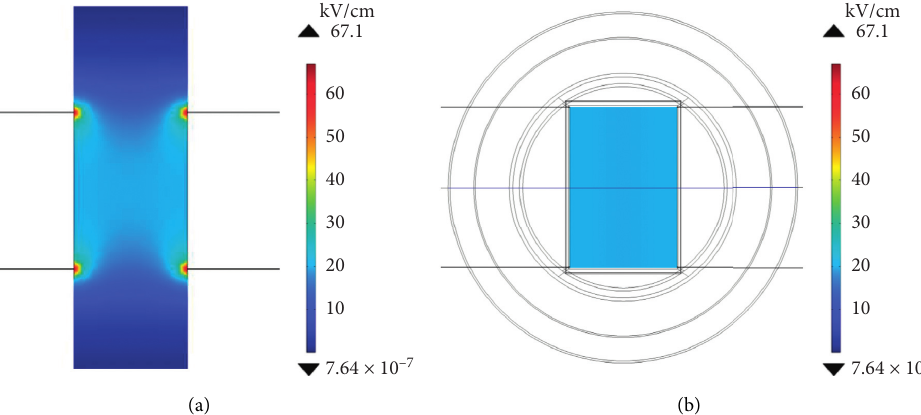
Figure 11: Electric field profiles that have been predicted in the treatment zone. The liquid is moving from bottom to top and is influenced by the gravitational acceleration constant of 9.81m/s 2 . (a) The view was taken from the coronal plane. (b) The view was taken from the transverse